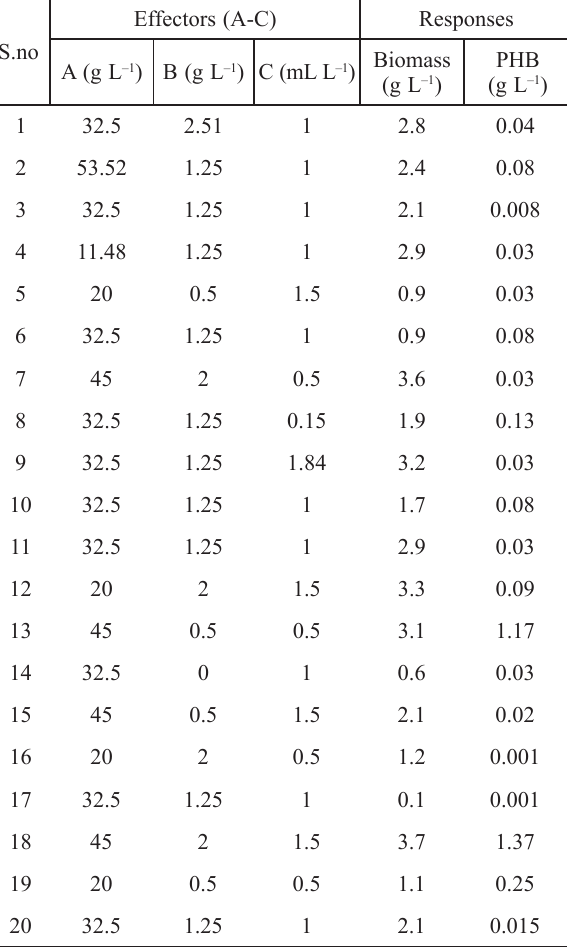
Table 4 – Experimental Design for Response Surface Meth- odology for three effectors along with their re- sponses